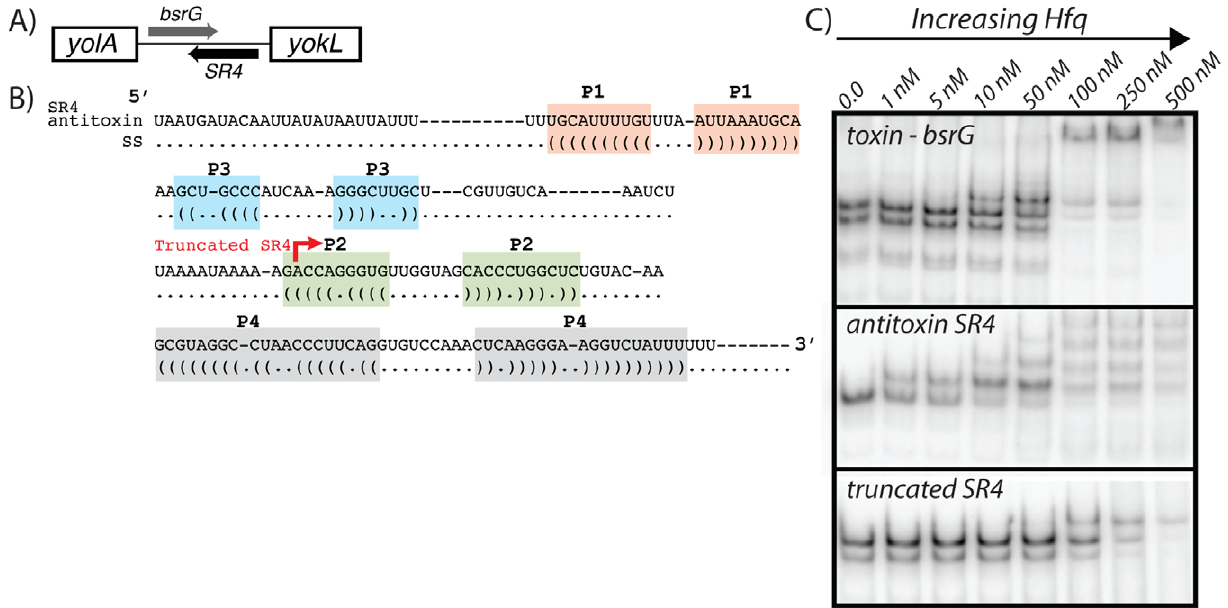
Figure 6. Hfq associates with type I toxin and antitoxin transcripts in vitro. (A) A schematic is shown for one of the four putative type I toxin:antitoxin systems that have been identified in B. subtilis . The primary sequence for the antitoxin is shown in (B), and colored regions denote portions of putative secondary structure. (C) Electrophoretic mobility shift assays showing association of purified hexahistidine-tagged Hfq with 5 9 radiolabeled transcripts. For this experiment, the antitoxin sequence shown in (B) was transcribed in vitro by T7 RNA polymerase, except that three Gs were also added at the 5 9 terminus to aid efficiency of transcription initiation. The 5 9 terminus of the truncated antitoxin transcript is denoted by a red arrow. The radiolabeled transcripts were incubated with increasing concentrations of purified Hfq and resolved by nondenaturing polyacrylamide gel electrophoresis.